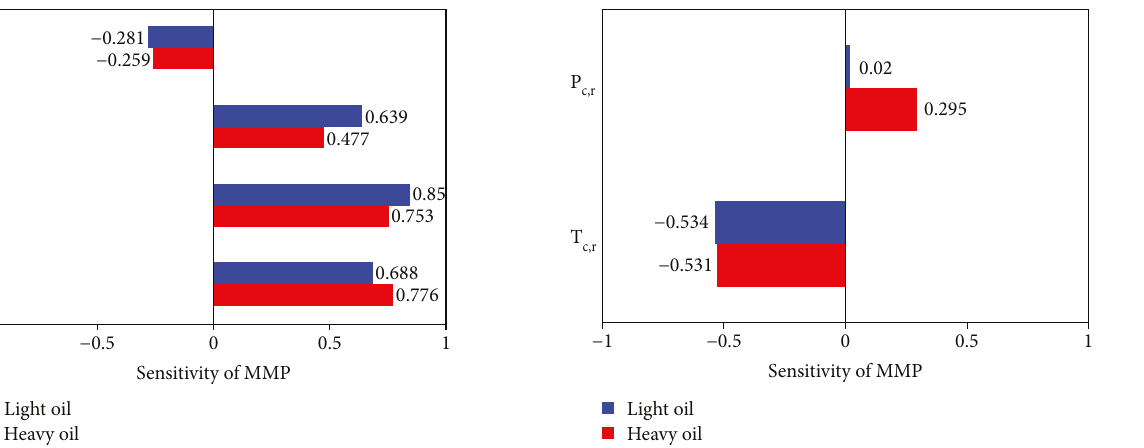
Figure 5: MMP sensitivity analysis of crude oil.